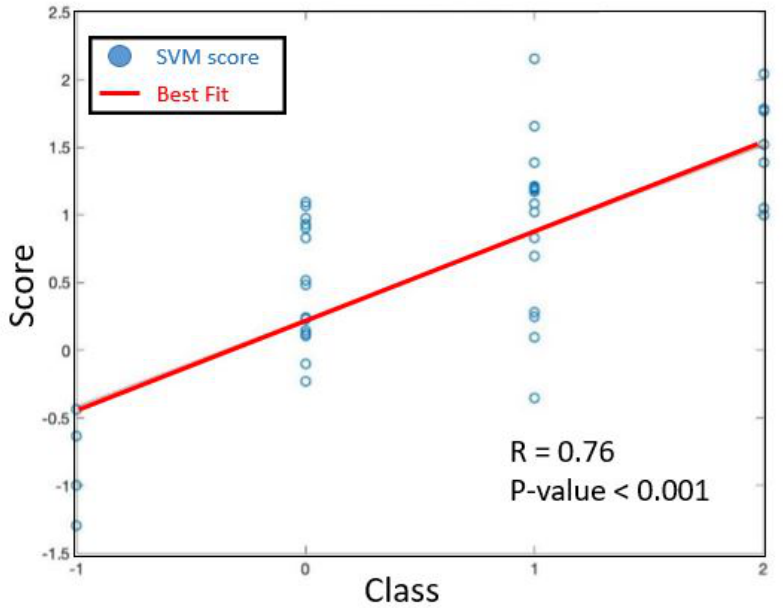
Figure 5. Distribution of the continuous output provided by the Support Vector Machine (SVM) model, along with the best-fit line.